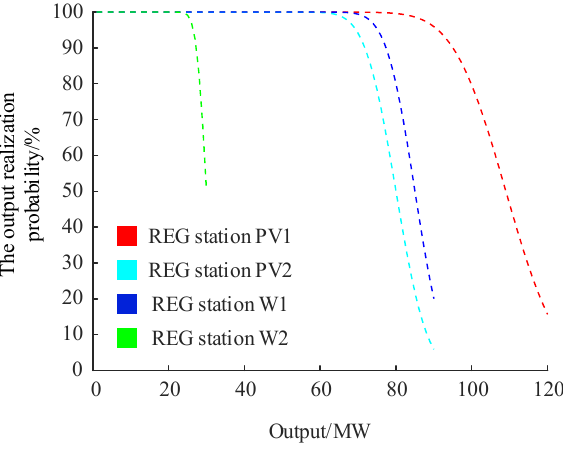
Figure 6. Probability density function of the predicted REG power error. According to the predicted output of each REG station and its probability density function, the output realization probability of each REG station can be obtained, as shown in Figure 7.